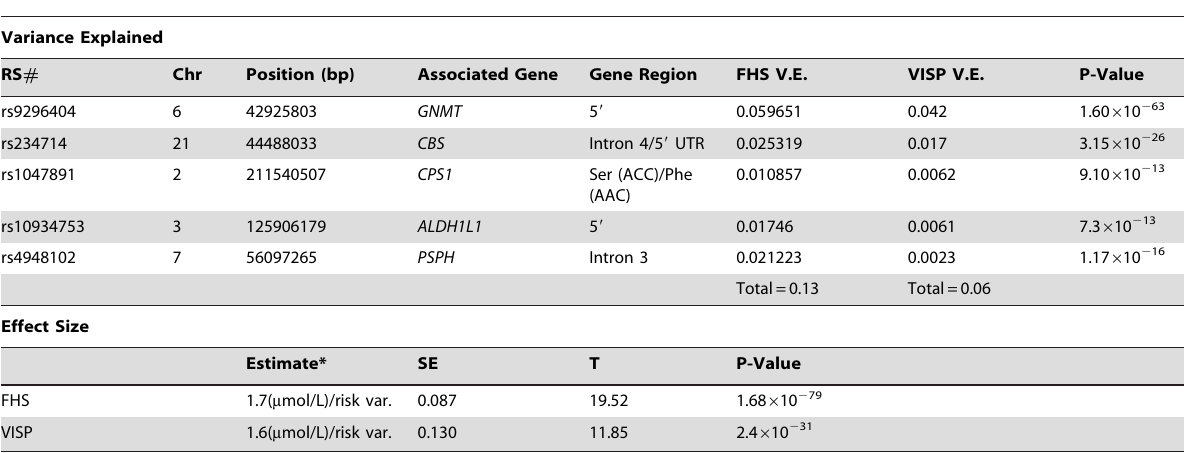
Table 3. Variance and effect size explained by risk